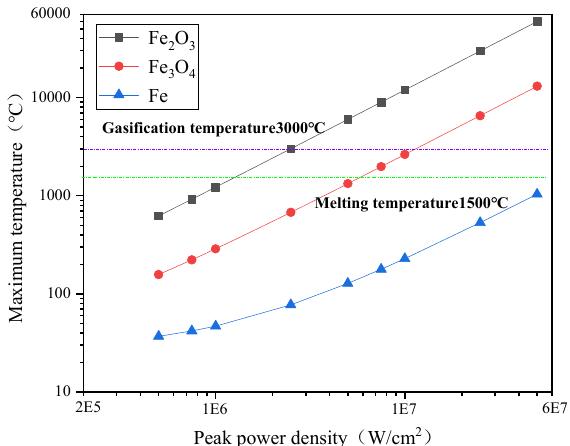
Figure 4. The relationship between the temperature of each layer material and the peak power.